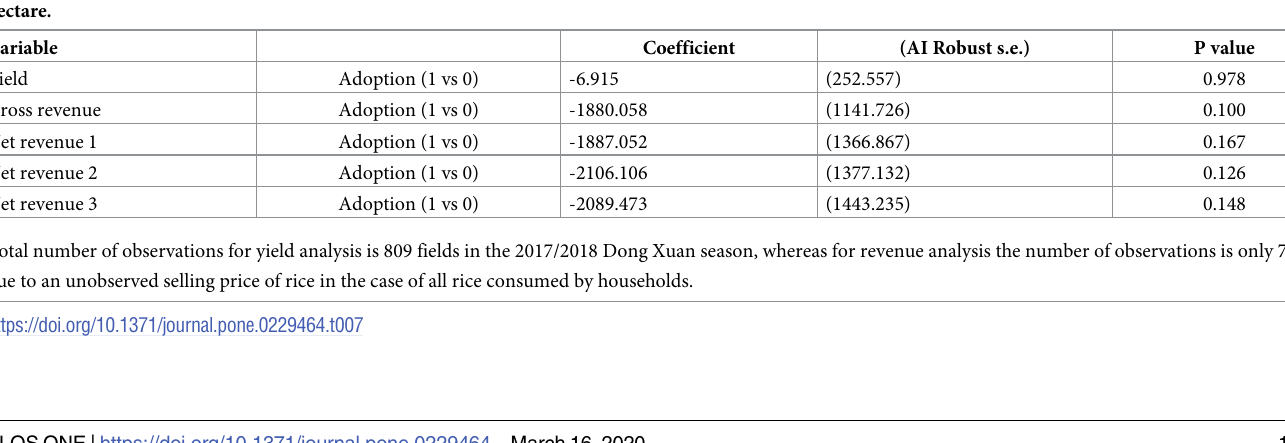
Table 7. PSM model using one nearest-neighbor matching that compares adopting and not-adopting fields in terms of yields, gross revenues, and net revenues per hectare. Variable